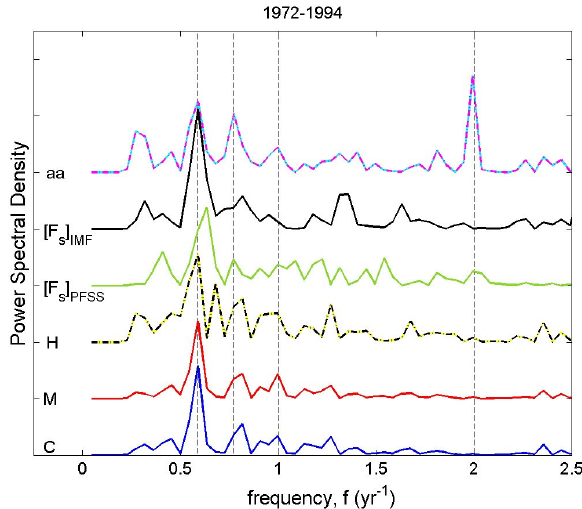
Fig. 3. Stacked power spectra for 1972–1994. All data have been Fourier analysed after being passed through a high pass filter ( f > 0.2 yr -1 ) to suppress the solar cycle variation. From bottom to top: Climax neutron monitor (>3GV) counts, C (blue); Moscow neutron monitor (>4GV) counts, M (red); Huancayo/Hawaii neutron monitor (>13GV) counts, H (black and yellow dashed); open solar flux deduced from photospheric magnetograms by the PFSS method, [ F s] PFSS (green); open solar flux deduced from the radial interplanetary magnetic field measured near Earth, [Fs]IMF (black); the aa geomagnetic index (light blue and mauve). Vertical dashed lines mark periods of 1.68 yr, 1.30 yr, 1.00 yr and 0.50 yr.